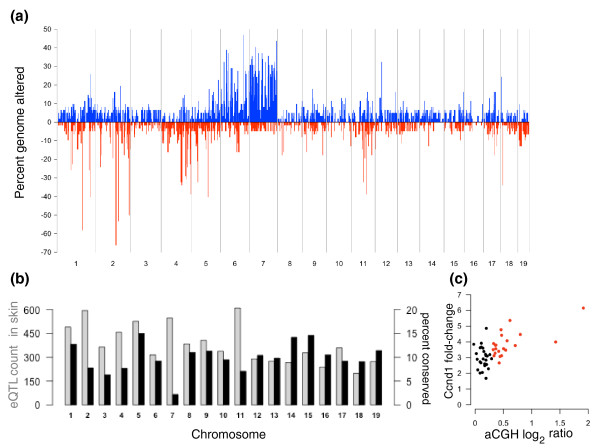
DNA copy number changes reduce germline influence. (a) Percentage of carcinomas with alterations across the mouse genome; amplifications (blue) plotted above zero, deletions (red) below zero. Chromosome 7 is most frequently amplified. (b) Counts of eQTL in skin on autosomal chromosomes (grey bars) compared to percentage of those eQTL conserved in carcinomas (black bars). Left-side scale indicates eQTL counts, right-side scale indicates conservation percentage. Conservation percentage is lowest on chromosome 7. (c) Amplification of aCGH probe MouseArray1M2_K17, at chromosome 7, 144.5 Mb, is significantly associated with increased expression of Cyclin D1 in carcinomas compared to matched normal skin. Amplification of this region of distal chromosome 7 accounts for loss of eQTL for Cyclin D1 and other genes in this region.